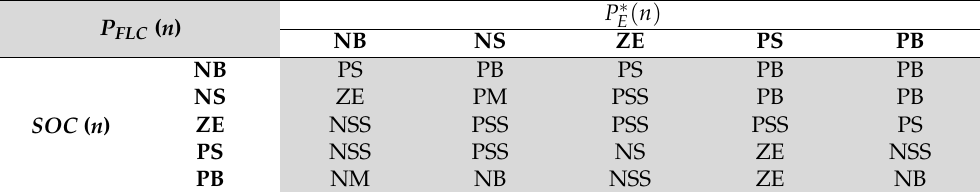
Table 5. Optimized rule base through Differential Evolution (DE)